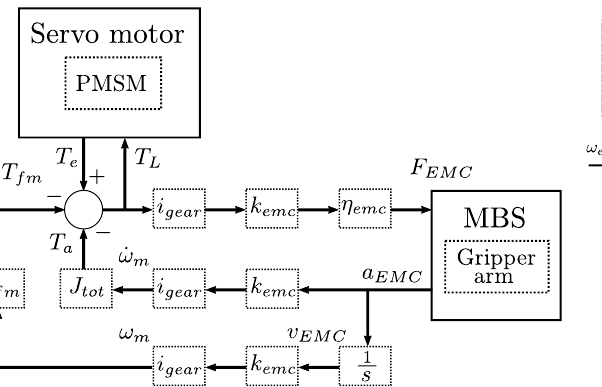
Figure 9: Transmission model sub-system.